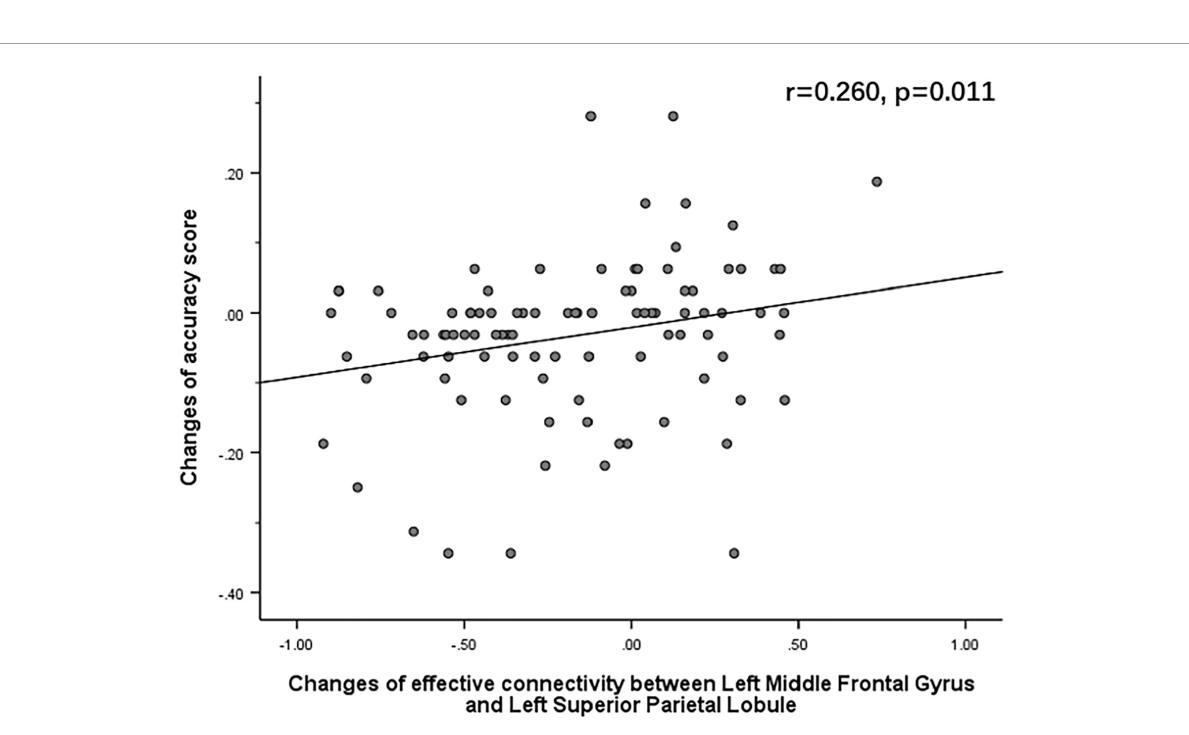
FIGURE11 After sleep deprivation, there was a positive correlation, under the identical condition, between the change in effective connectivity from the left middle frontal gyrus to the left superior parietal lobule ( t 95 = 4.203, p < 0.004) and change in accuracy ( r = 0.260, p =